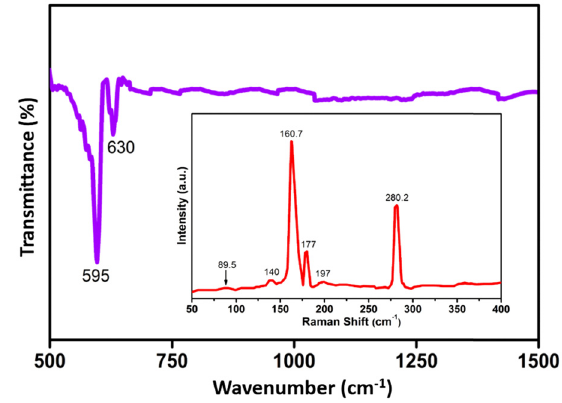
Figure 4: FTIR and Raman ( inset ) spectra of Tl 2 S thin fi lms fabricated at 600°C on the FTO substrate using the AACVD